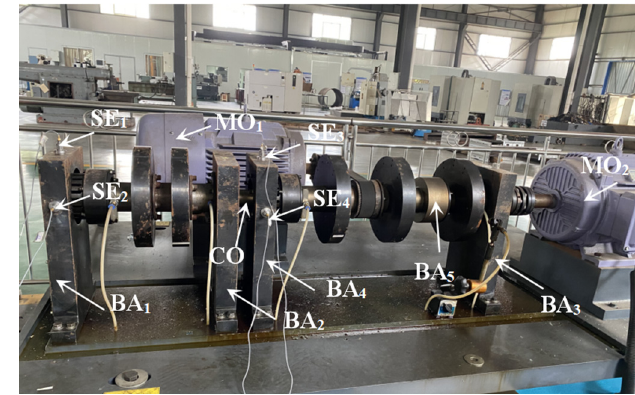
Fig. 2. The experimental rig.